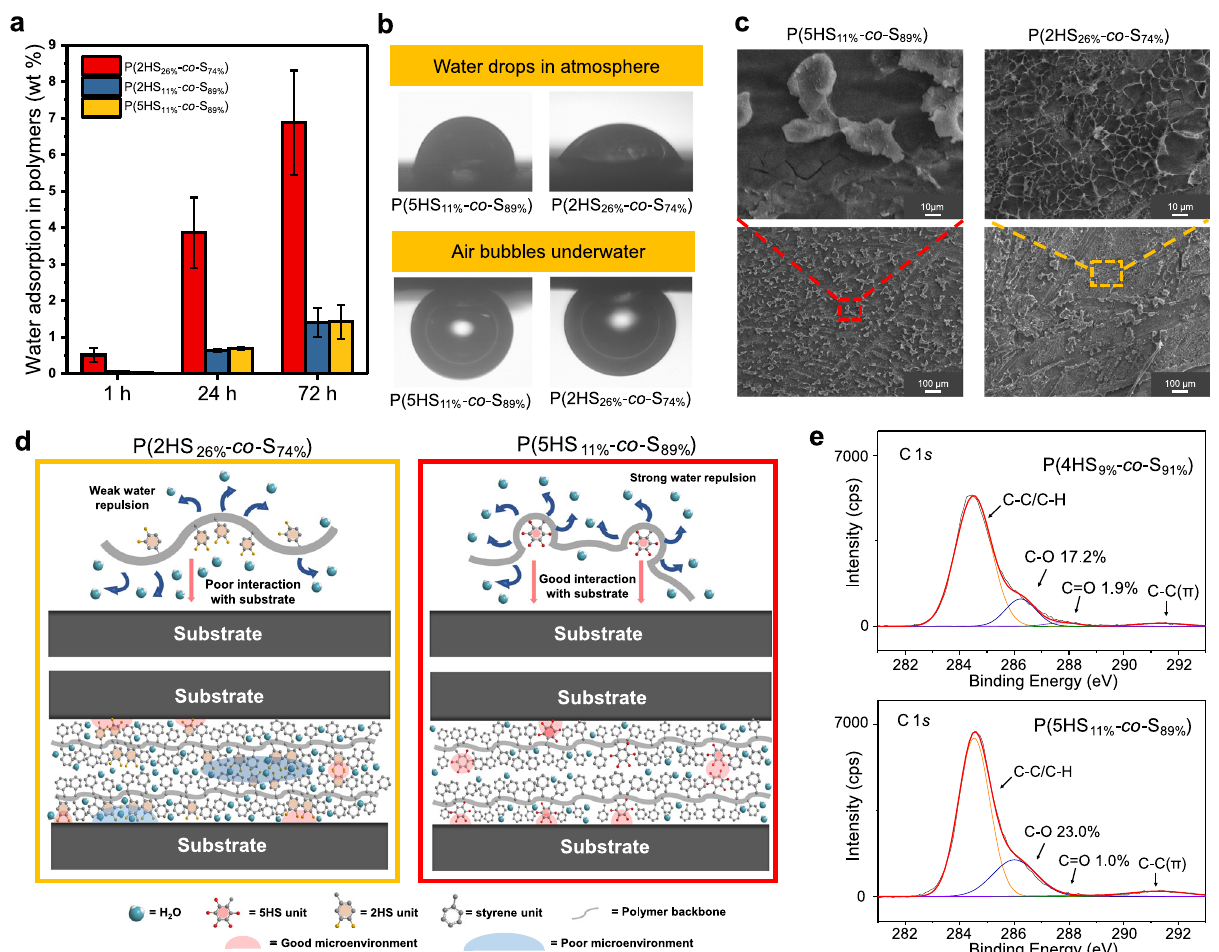
Fig. 3 Spatially con fi ned phenolic groups reduce water uptake. a Comparison between water uptake of P(2HS 26% -co -S 74% ), P(2HS 11% -co -S 89% ) and P(5HS 11% -co -S 89% ) via QCM. The results represent the mean ± s.d. ( n = 3). b Surface contact angle images of fractured aluminum surfaces containing P(5HS 11% -co -S 89% ) and P(2HS 26% -co -S 74% ) in air and in water. c SEM images of fractured aluminum surfaces containing P(5HS 11% -co -S 89% ) (left, red) and P(2HS 26% -co -S 74% ) (right, yellow). d Proposed mechanism of water-shielding at the interface between the substrate and polymers. e XPS spectra of fractured aluminum surfaces containing P(4HS 9% -co -S 91% ) and P(5HS 11% -co -S 89%